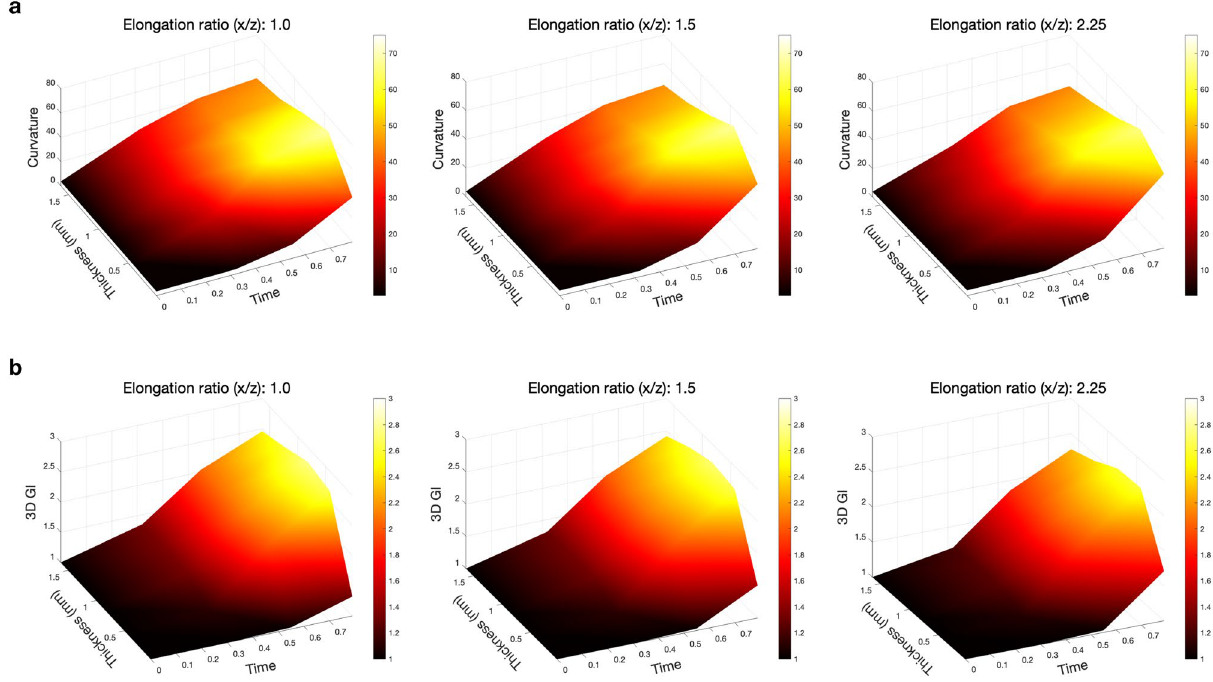
Figure 6. The comparison of ( a ), average of absolute value of dimensionless mean curvatures and ( b ), 3D GI over time for geometries with different initial cortical thicknesses and elongation